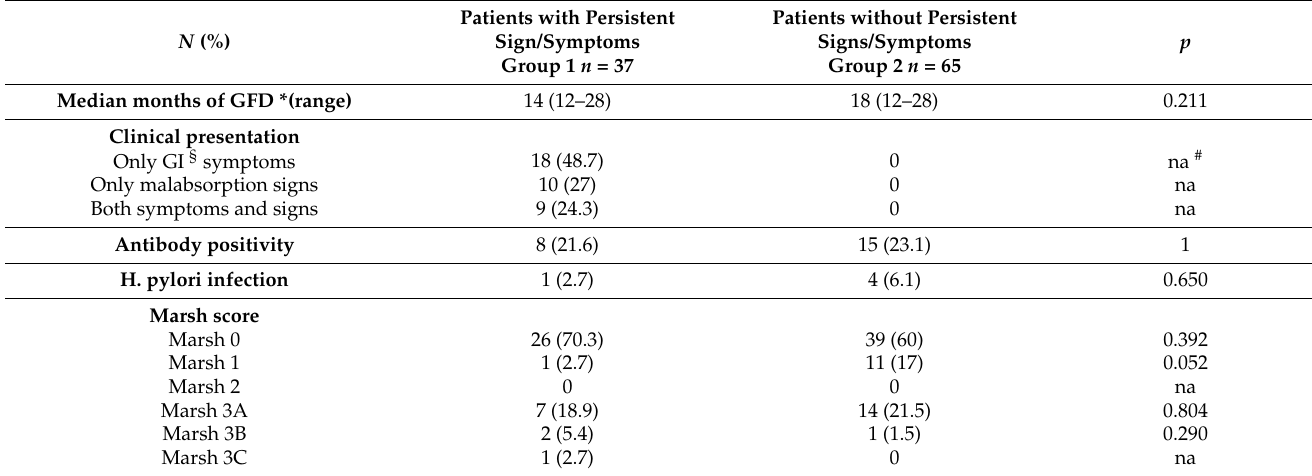
Table 2. Comparison of clinical, serological and histological features at the time of histological re-evaluation among patients with or without persistence of GI symptoms/malabsorption